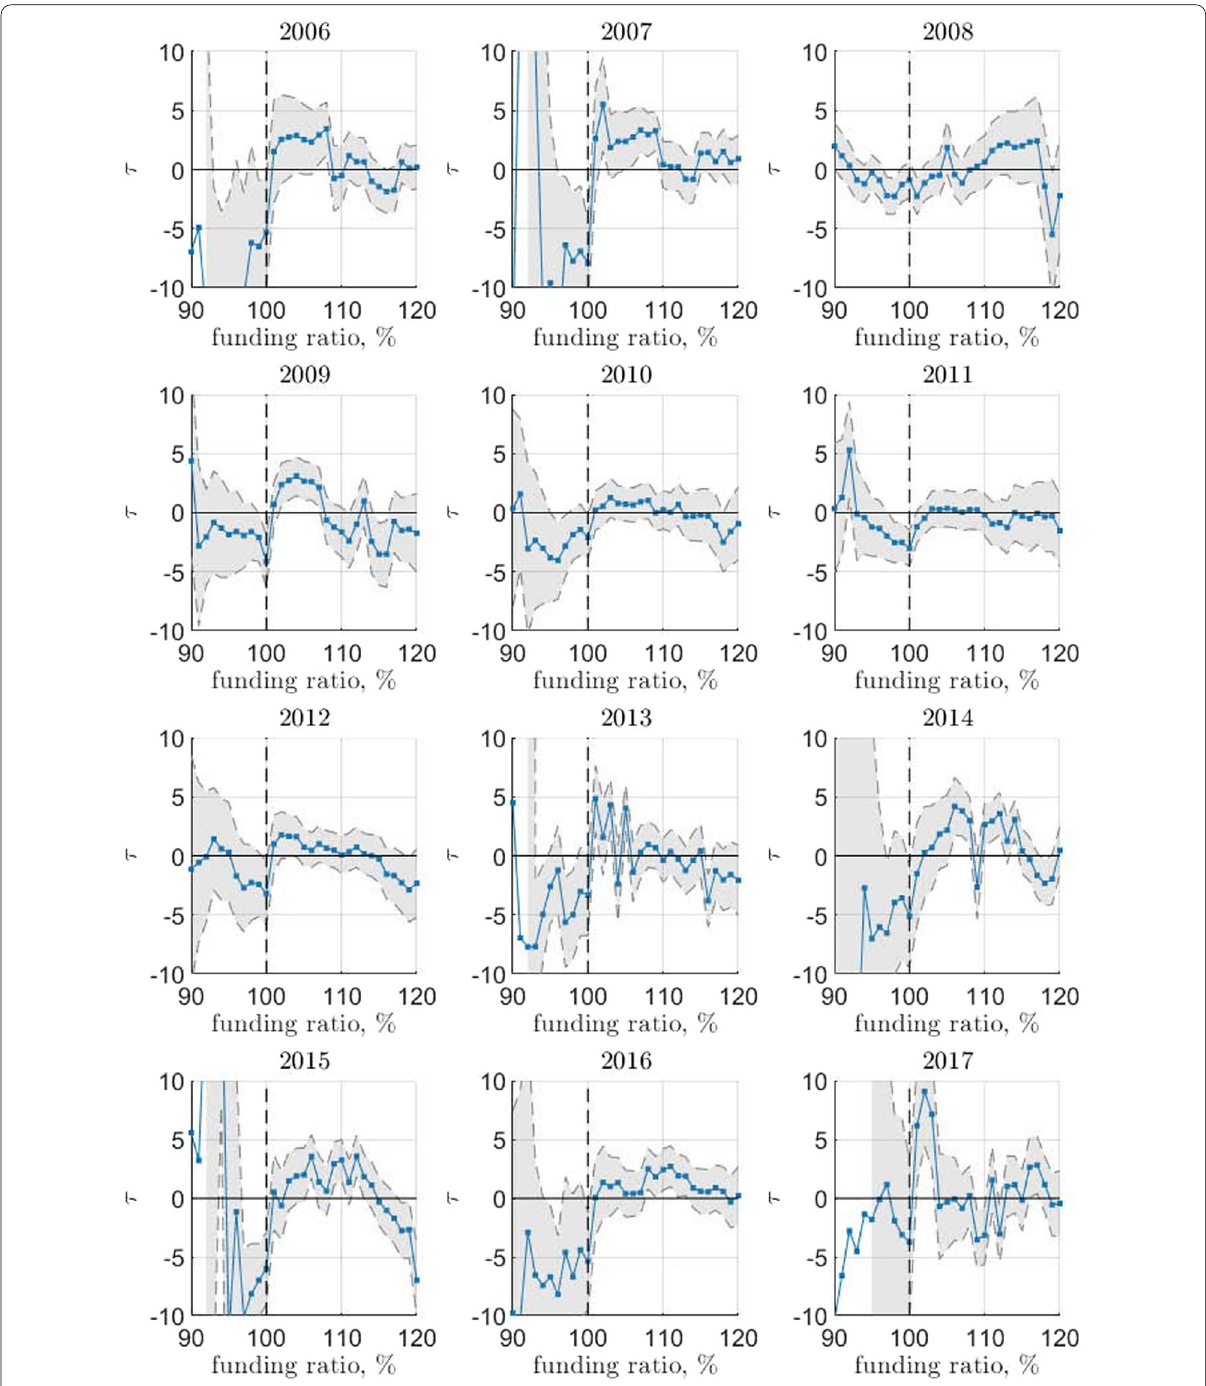
Fig. 12 Estimates for τ at Alternative Cut-offs. Figure shows the coefficients for τ estimated for varying alternative cut-offs c , using the global polynomial regression specification. The gray area indicates the 95% confidence bands from bootstrapped standard errors (500 iterations). Confidence bands are below zero, mostly only at c = 100% . Compared to alternative cut-offs, the specification with c = 100% appears to yield the estimate that is most significantly different from zero in almost all years. The sample includes only private and public funds without state guarantees, and includes only funds with a funding ratio between 81.5 and 152.3% (0.5th–95th percentile